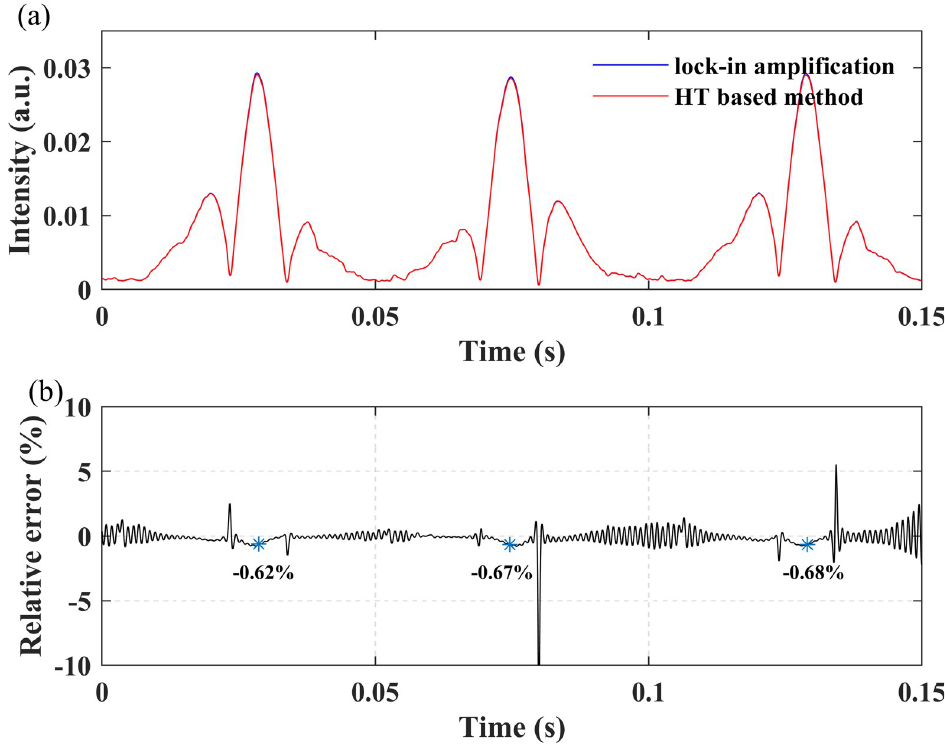
Fig 8. Experiment results: (a) Second harmonic demodulated by the two methods; (b) The relative error.